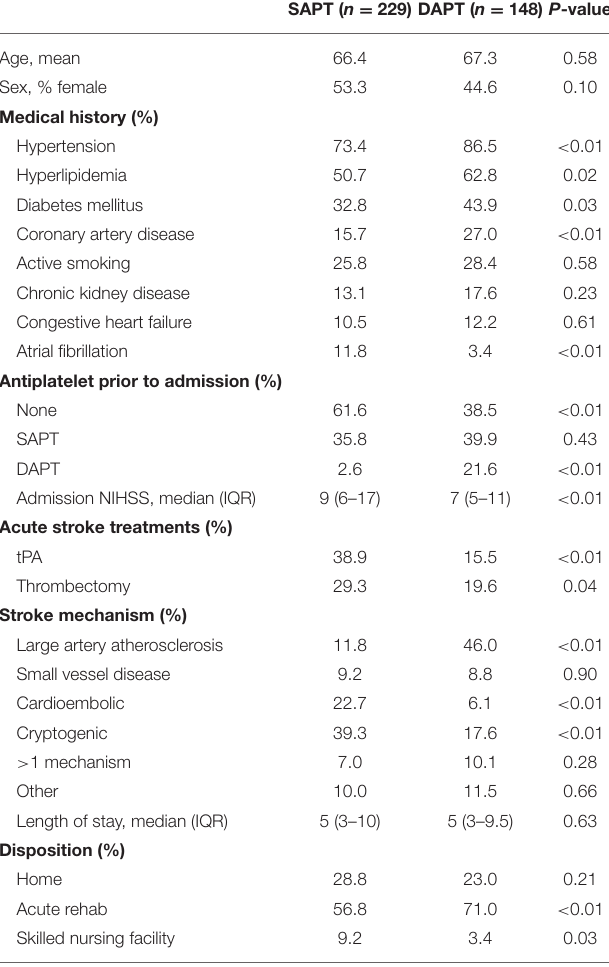
TABLE 1 | Baseline characteristics.